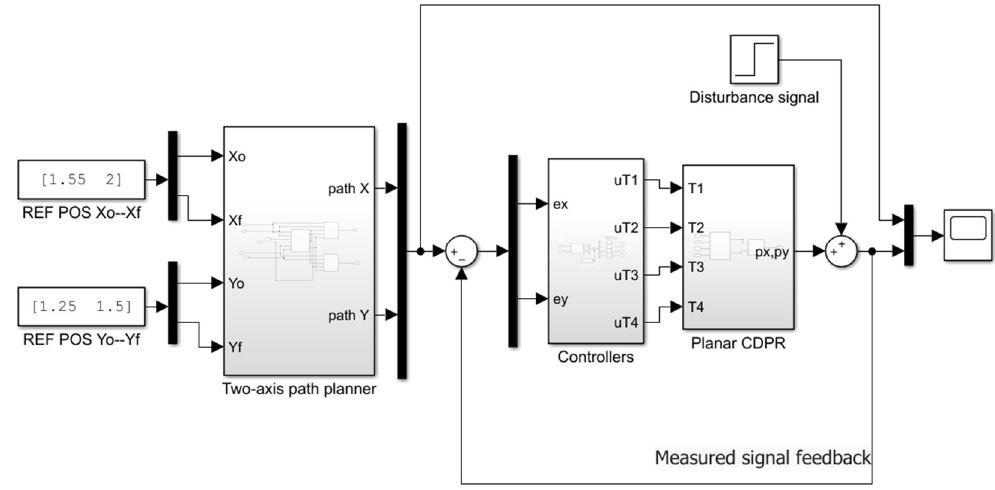
Figure 20. Control system of a planar CDPR.